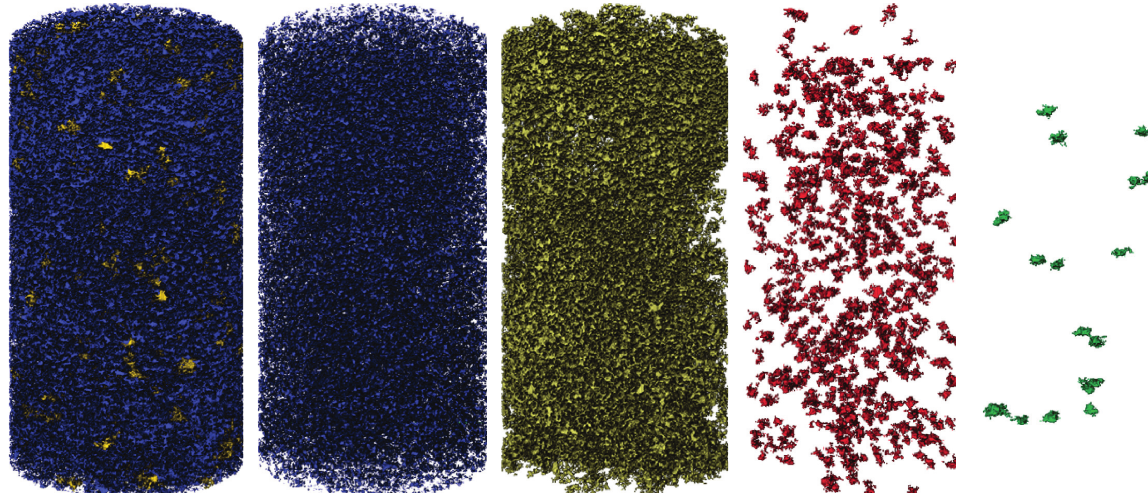
Figure 9: Spatial distribution of the pore structure of sample D-S-3.